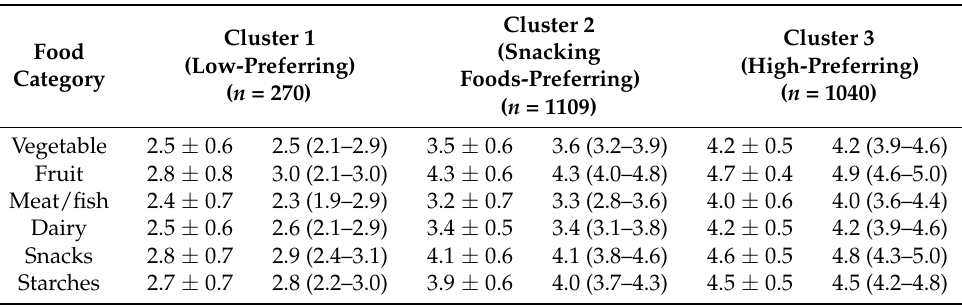
Table 3. The food preferences for sub-groups stratified based on the clustering of the preferences assessed by Food Preference Questionnaire (FPQ) within the population of the second phase of the Polish Adolescents’ COVID-19 Experience (PLACE-19) Study ( n = 2419) (distribution different than normal for all the variables, except for dairy for cluster 1, verified using Shapiro-Wilk test— p ≤ 0.05).